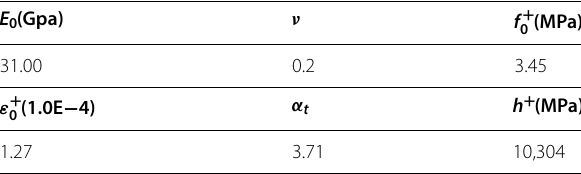
Table 4 Material parameters used for the monotonic uniaxial tensile